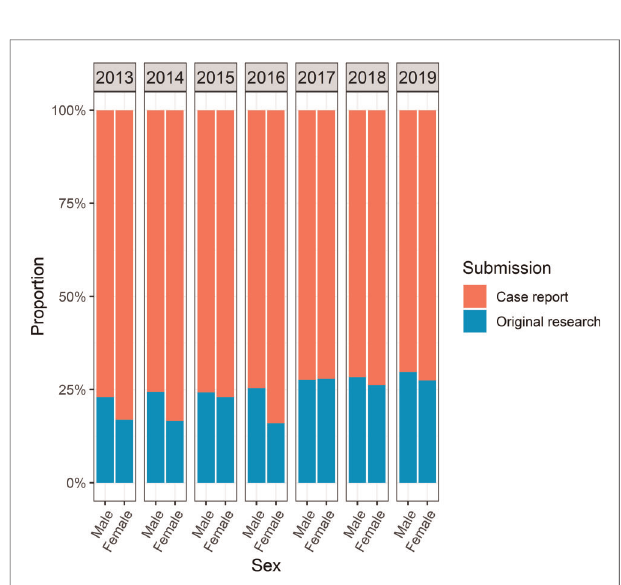
FIGURE 5 | Comparison of abstracts accepted to AMCG annual meeting from 2013 to 2019 by sex and study design (case report, original